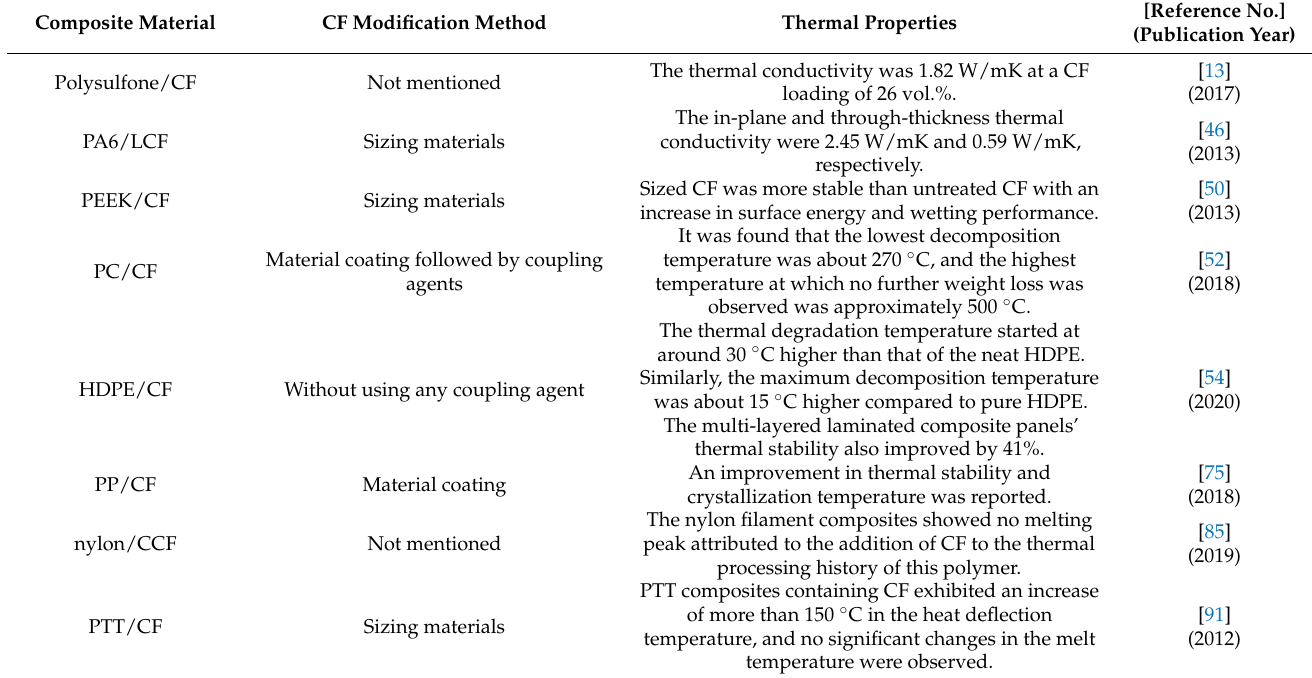
Table 4. The type of thermoplastic polymer and CF, modification techniques of CF, and thermal properties of different CFRTP